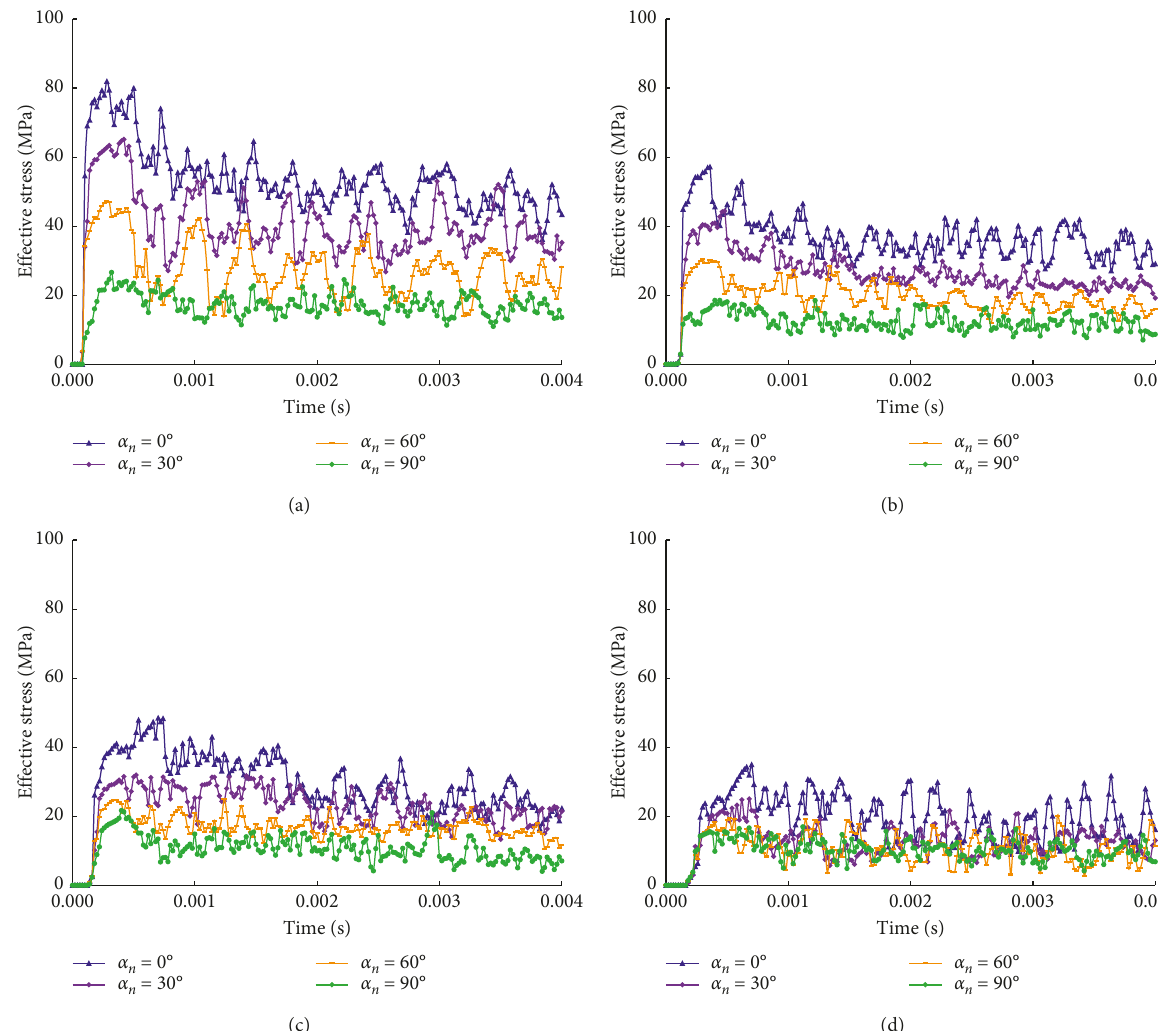
Figure 18: Effective stress curve of different monitoring points of #3 simulation case. (a) D r b �